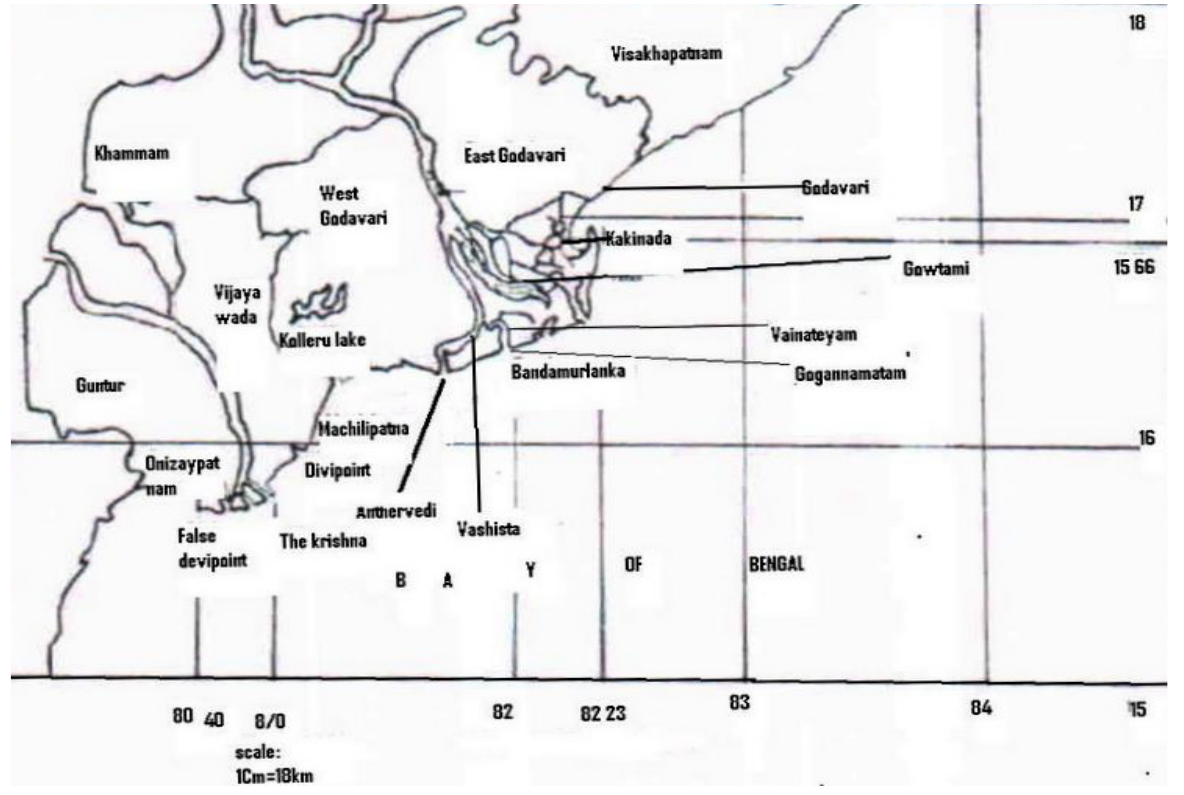
Fig. 1. Vashista and Vainateyam